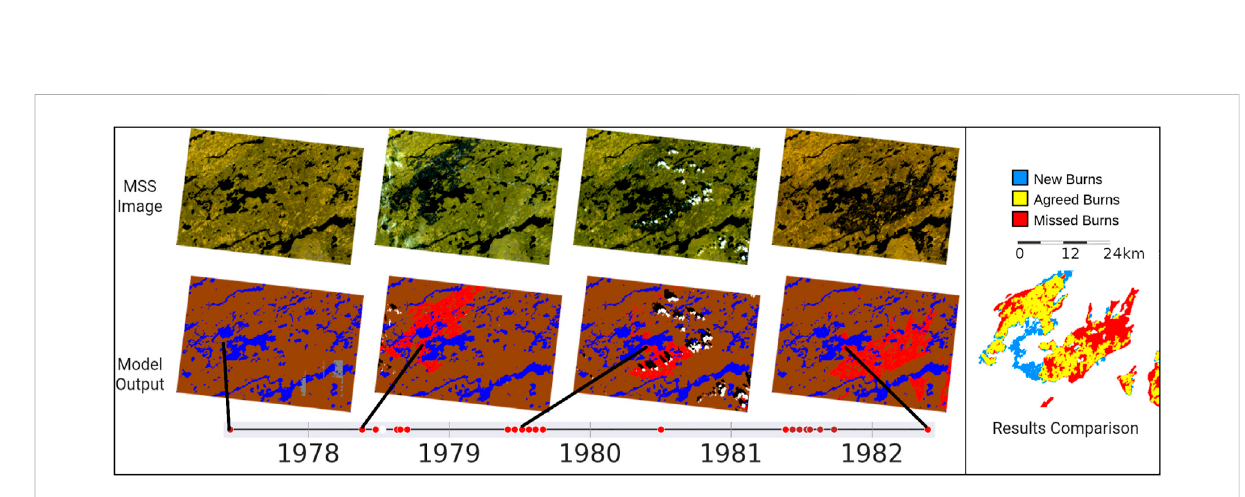
FIGURE 7 Results Detail E. MSS images and model classi fi cations of a fi re detected by our methods and listed in the existing databases, along with a timeline of each model classi fi cation for a single